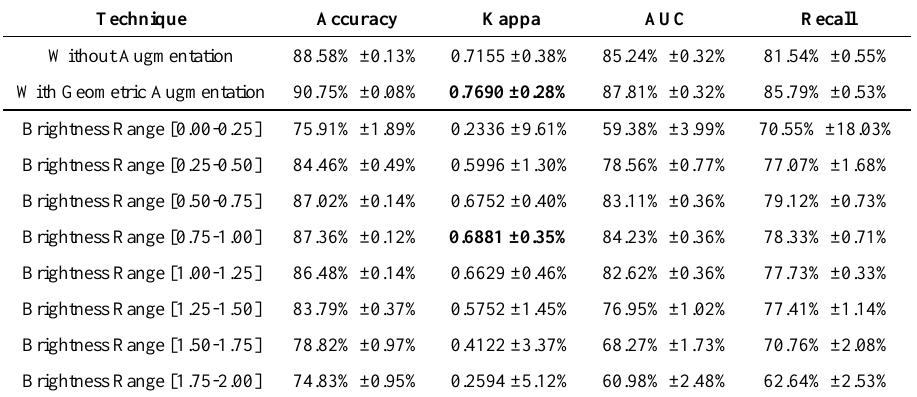
Table 1. Results of ResNet50 network. (± 95% confidence interval over repeated trials) Technique